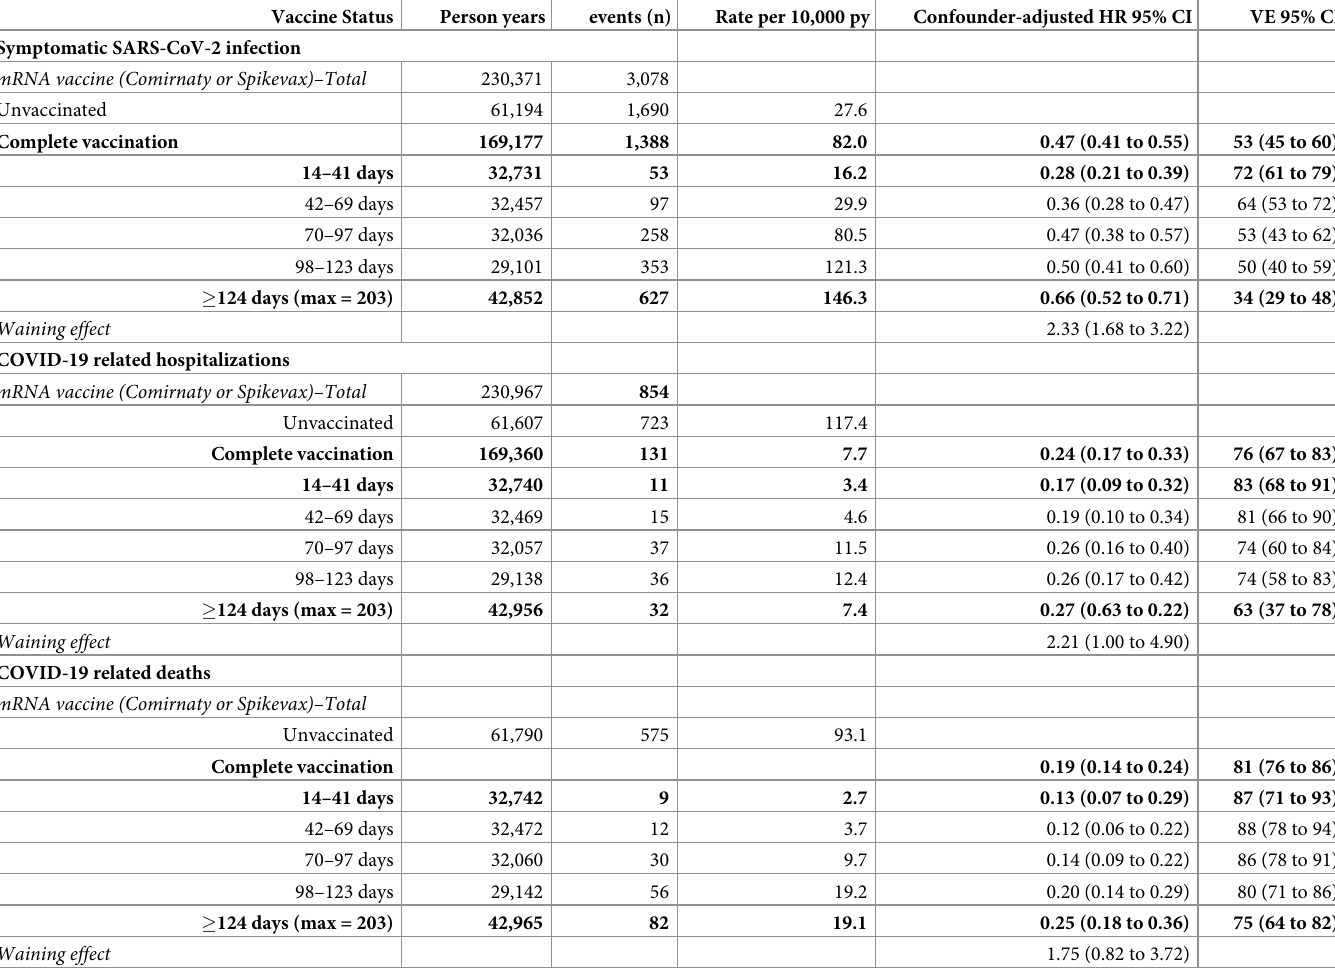
Table 2. Symptomatic SARS-CoV-2 infection, COVID-19 related hospitalizations and deaths, incidence, hazard ratios and vaccine effectiveness by mRNA (Comir- naty or Spikevax) vaccination status for individuals aged � 80 years, Portugal, February–September 2021 (n =